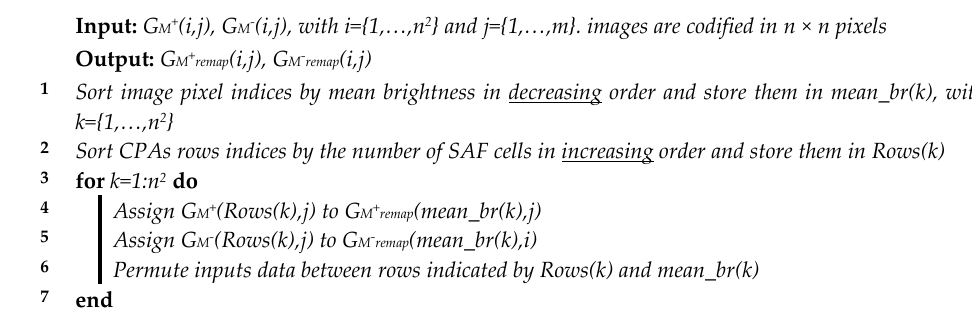
Algorithm 3: Mean-bias-dependent mapping